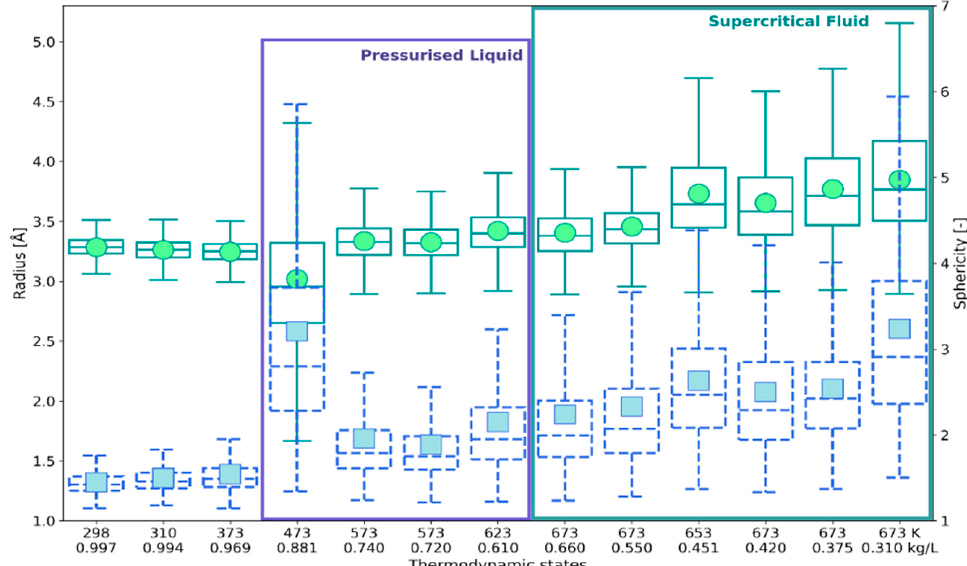
Figure 7. Box-and-whiskers plots of face-weighted radius R w (circles, solid contours, left axis) and asphericity factor α (squares, dashed contours, right axis).